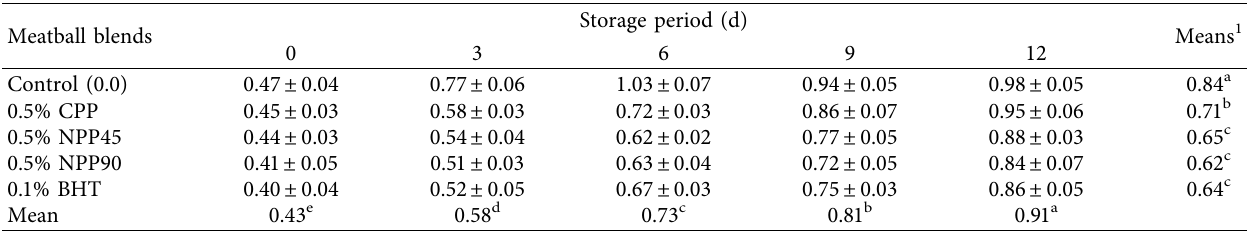
Table 2: Impact of nano-pomegranate peel on the peroxide value (meq peroxide/kg lipid) of cold stored meatballs. Meatball blends Control